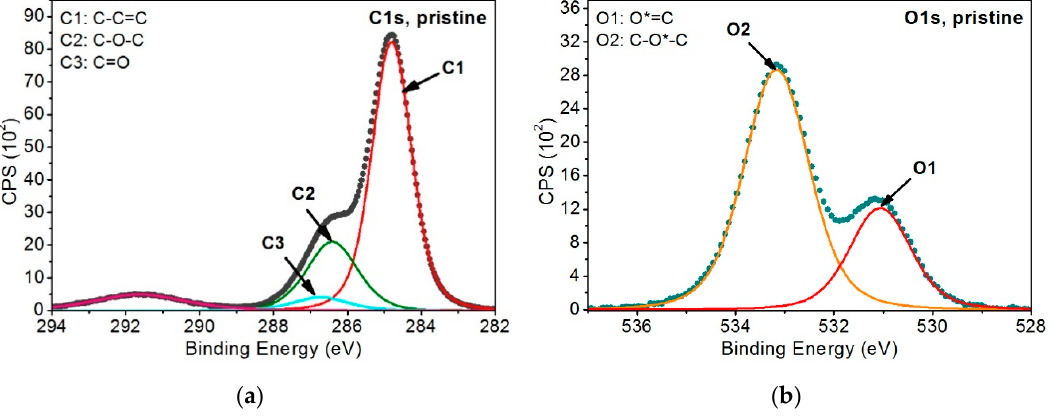
Figure 6. XPS spectra of non-modified PEEK: ( a ) C1s band, ( b ) O1s band.